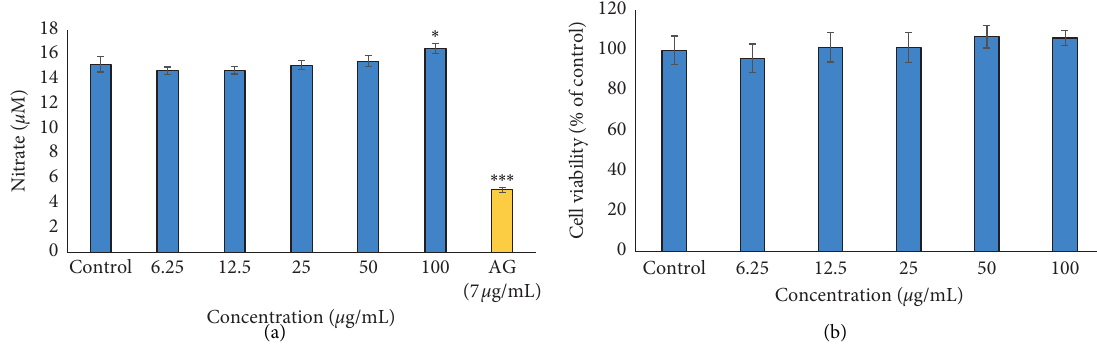
Figure 5: Effect of the ethanol extract of B. asphodeloides on (a) NO production in LPS-activated RAW 264.7 cells. (b) Corresponding cell viability is also shown. AG: aminoguanidine. Data are presented as the mean ± SD ( n � 3). ∗ P < 0 . 05 and ∗∗ ∗ P < 0 . 001 compared to the control.